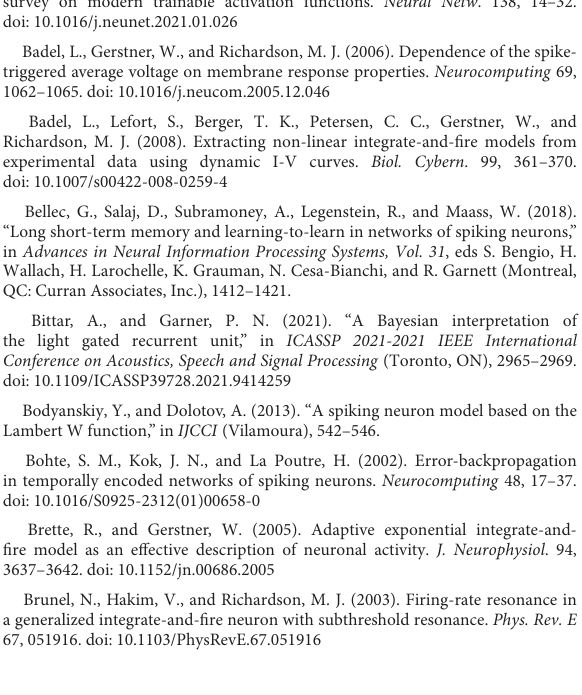
SUPPLEMENTARYFIGURE1 Convergence plot of the RadLIF network on the SC dataset. SUPPLEMENTARYFIGURE2 Convergence plot of the GRU network on the SC dataset. SUPPLEMENTARYFIGURE3 Convergence plot of the adLIF network on the SHD dataset. SUPPLEMENTARYFIGURE4 Convergence plot of the GRU network on the SHD